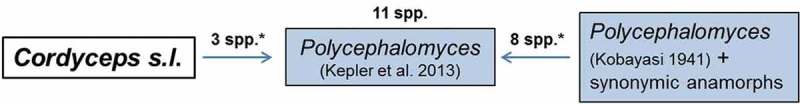
Species composition of Polycephalomyces. * indicates the no. of spp. transferred from one genus to another.